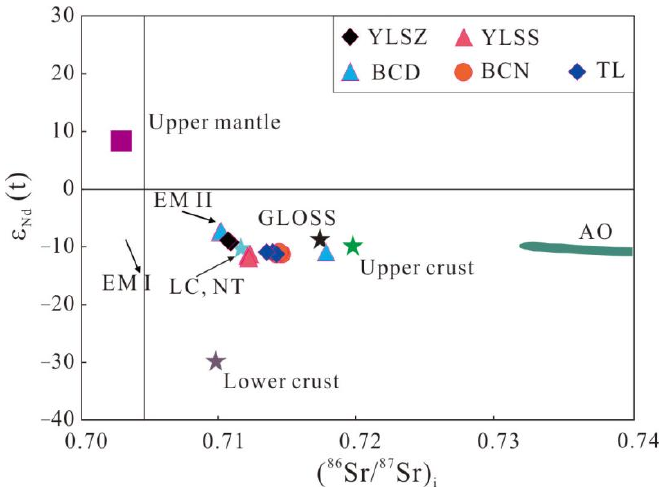
Figure 8. ( 87 Sr/ 86 Sr) i versus ε Nd (t) diagram for the Yilashan and Amdo granitoids in the Nagqu area. Upper mantle and upper crust data are from [81], and lower crust data are from [82]. Data for global subducting sediments (GLOSS), Amdo orthogneiss (AO) and lower crust of northern Tibet are from [36,80,83], respectively. EM: enriched mantle. Symbols as in Figure 6.